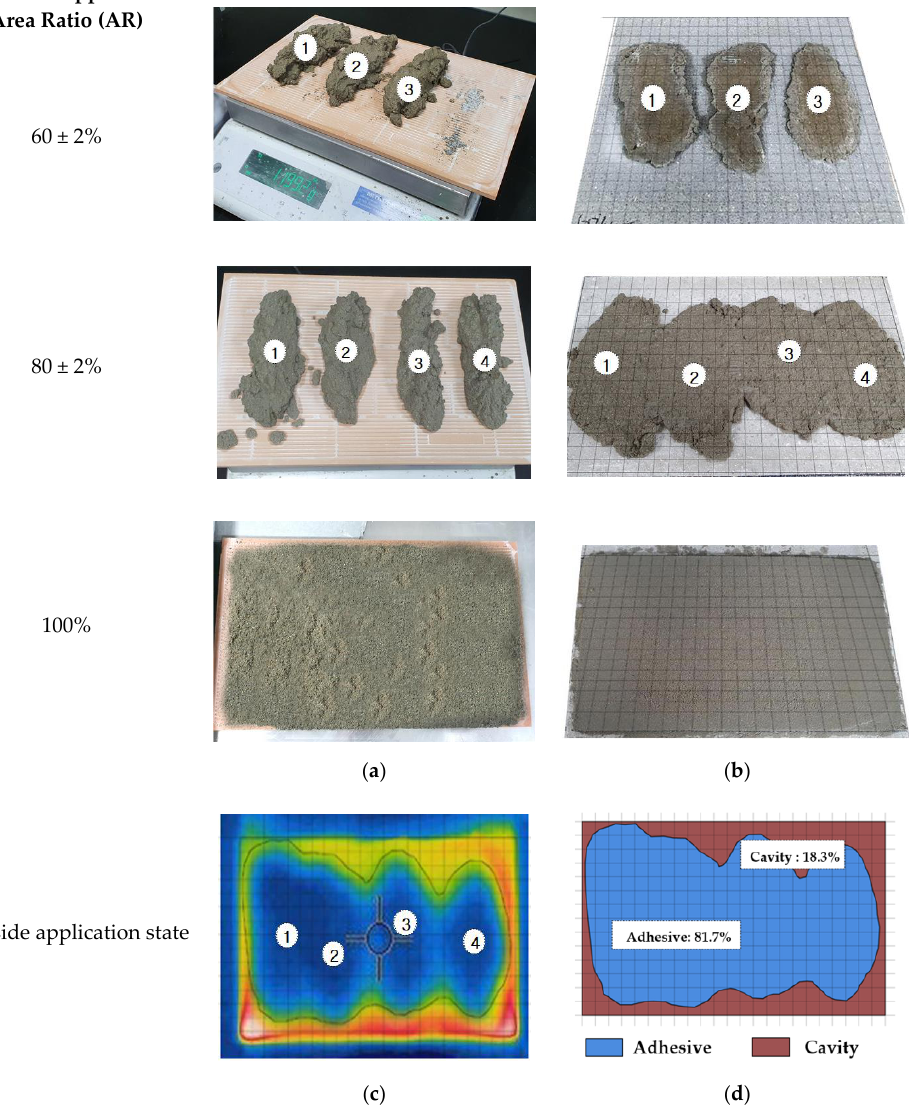
Figure 5. Spot-bonded mortar adhesion surface area determination process: ( a ) spot-bonded mortar; ( b ) adhesion on to concrete surface; ( c ) thermal emission imaging; ( d ) digital mapping.